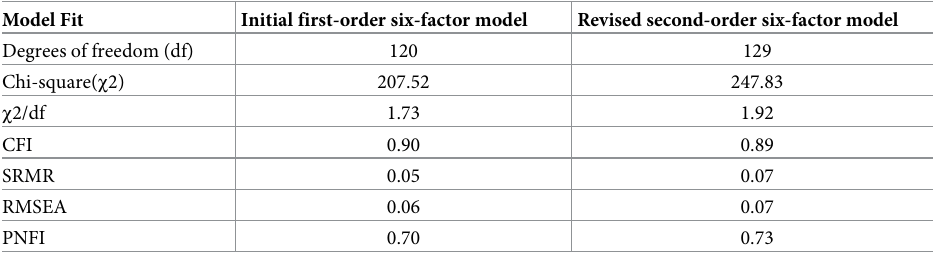
Table 3. Model comparisons of heritage